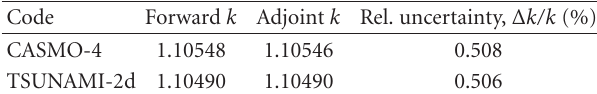
Table 2: Summary of the results for the multiplication factor.